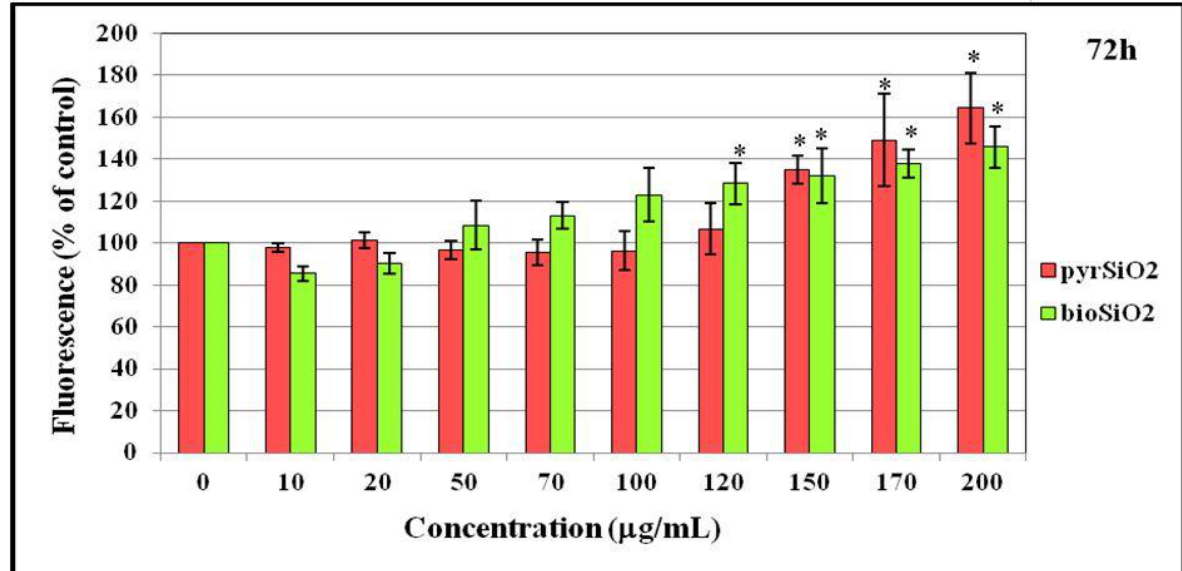
Figure 9. Intracellular reactive oxygen spices (ROS) generation in HMEC-1 cells. Production of ROS of human dermal microvascular endothelial cell line after treatment of silica nanoparticles (pyrogenic and biogenic). Statistical evaluation of differences was made using the ANOVA I and Tukey’s post hoc test, at significance levels of p < 0.01 (*) with respect to